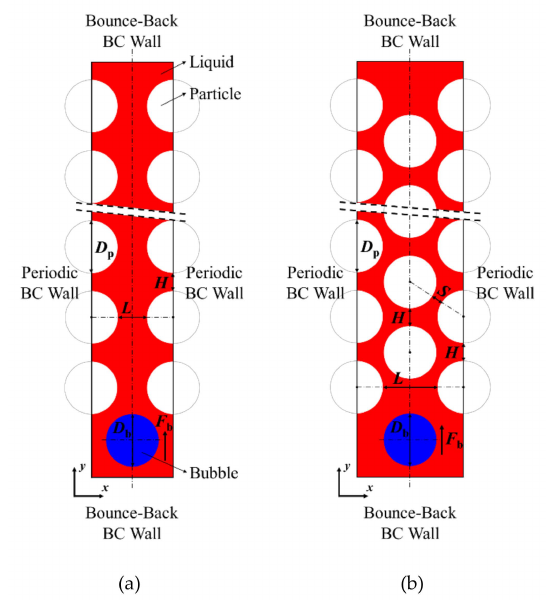
Figure 4. Schematics of wavy vertical channel ( a ) and S-shaped curved channel ( b